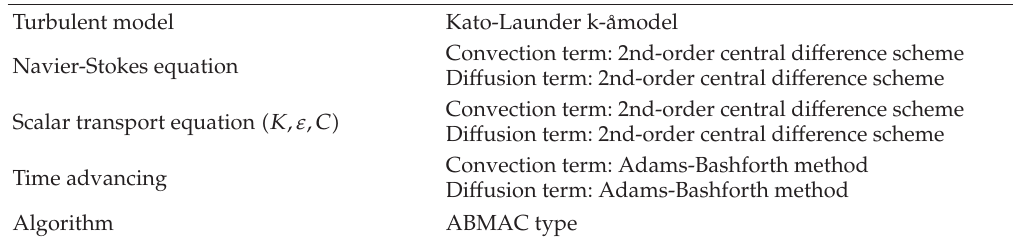
Table 1: Numerical simulation parameters.